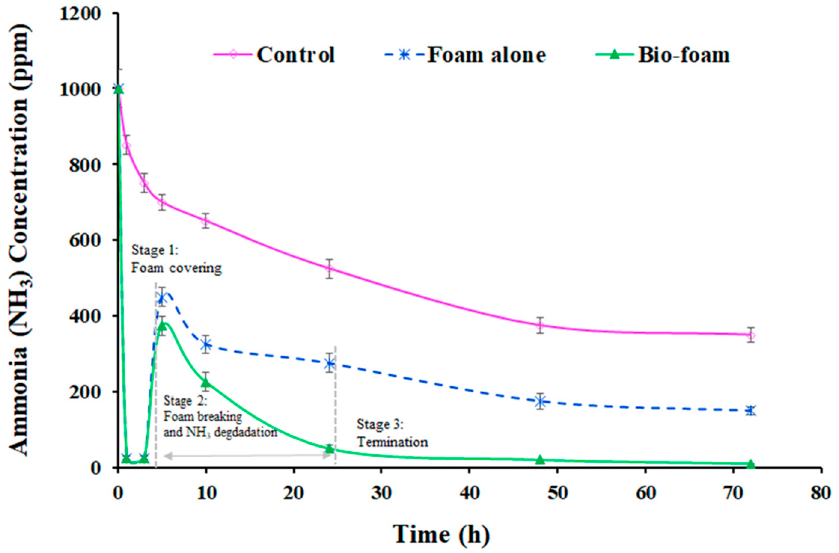
Figure 2. Change in NH 3 concentration from NH 3 -contaminated soil with time in the open reactor; control (no treatment), foam alone (application of surfactant foam only), and bio-foam (surfactant foam containing bacteria).